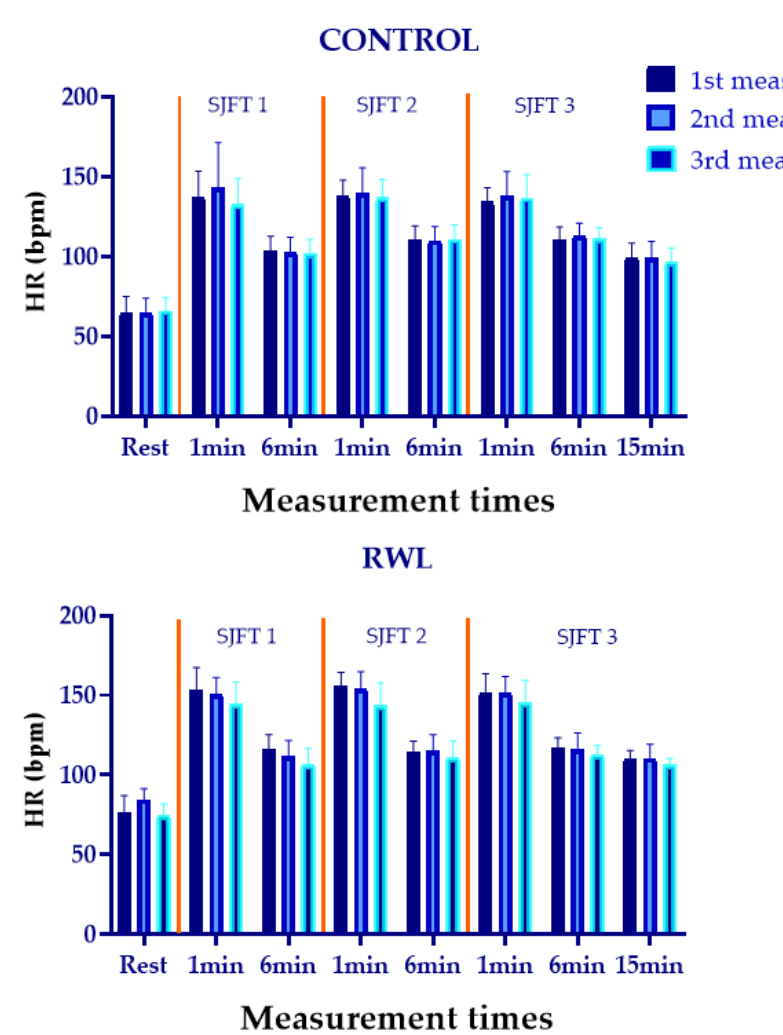
Figure 3. HR changes in RWL and control groups during SJFT performance and recovery.